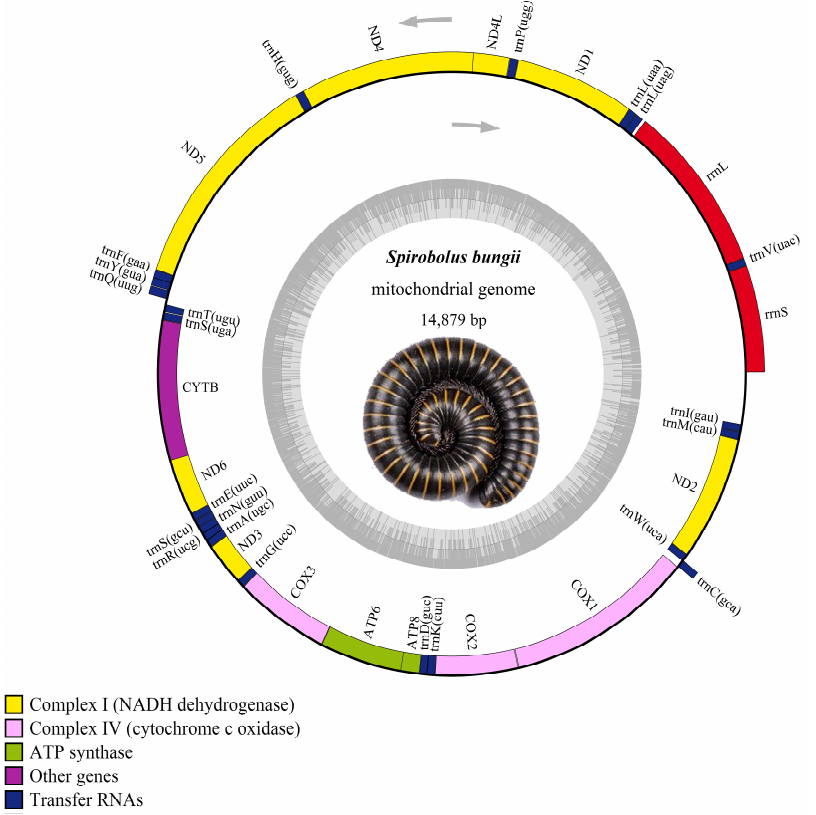
Figure 1. Circular map of the mitogenome of S. bungii . The circle shows the gene map of S. bungii where genes outside the map are coded on the major strand (J-strand), and those on the inside of the map are coded on the minor strand (N-strand). Genes are represented by differently colored blocks. Table 2. Mitogenomic organization of S. bungii .